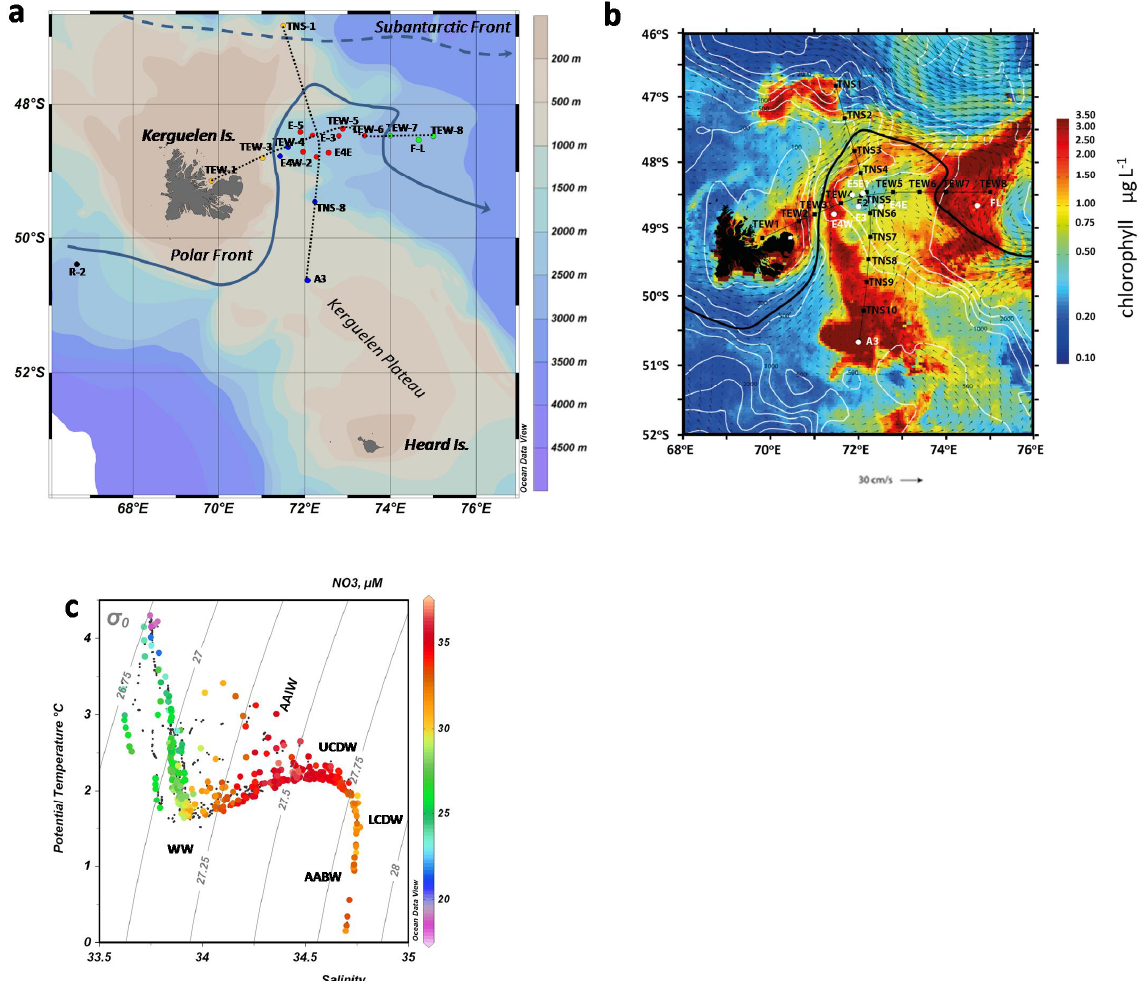
Figure 1. (a) Kerguelen area with KEOPS 2 sampling grid. Blue dots: “Plateau” stations; red dots: “Meander” stations; green dots: stations at the Polar Front and north of the PF; black dot: “reference” station; orange dots: stations outside the Plateau and Meander areas. The black line marks the position of the Polar Front. (b) MODIS chlorophyll distribution for second half of November 2011 (colour bar: µgL − 1 ); arrows represent the current speed, with scale marked by the small black arrow (30cms − 1 ) below the figure (courtesy F. d’Ovidio and Y.-H. Park); (c) T – S diagram (all stations) with [NO − ] superimposed. (ODV-AWI, R. 3